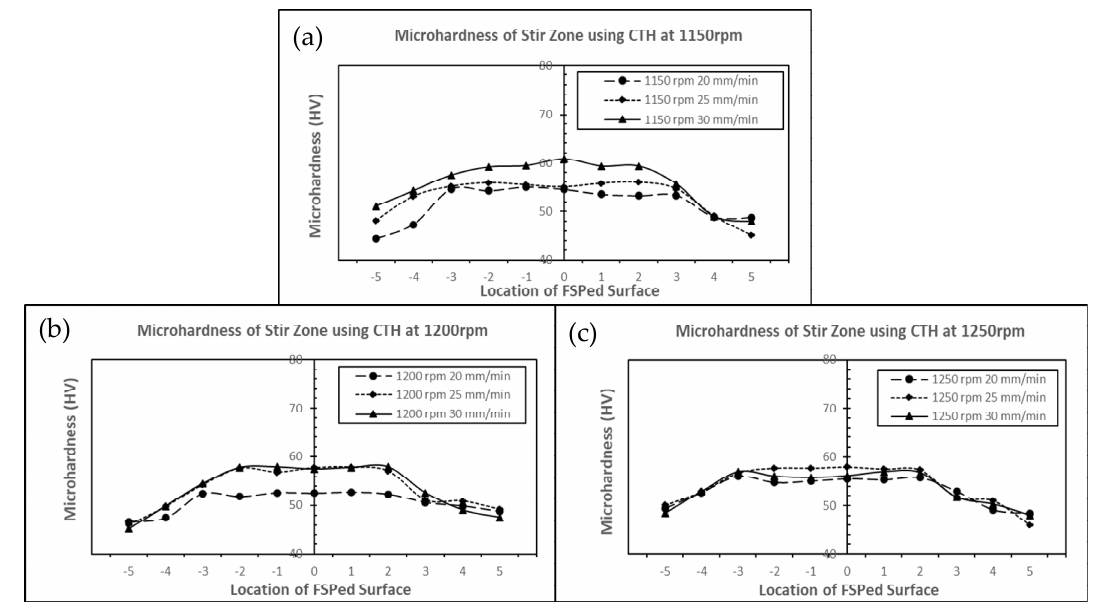
Figure 8. Stir zone microhardness of FSPed sample produced at, ( a ) 1150 rpm, ( b ) 1200 rpm, and ( c ) 1250 rpm using CTH tool with different feed rates.